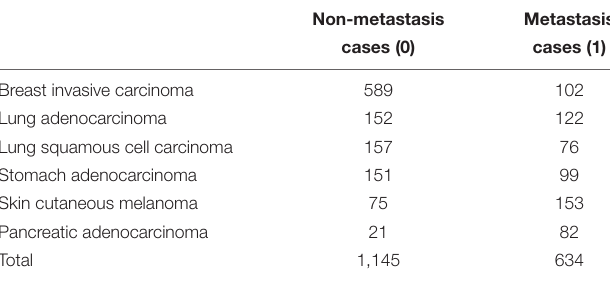
TABLE 1 | Number of positive and negative cases for each cancer